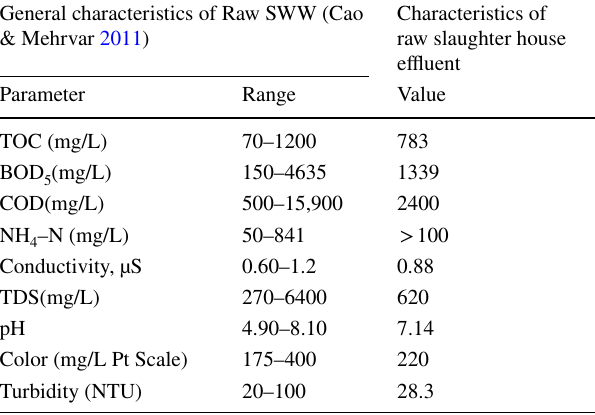
Table 1 General characteristics of Raw SWW (Cao & Mehrvar 2011) and slaughter house wastewater General characteristics of Raw SWW (Cao & Mehrvar